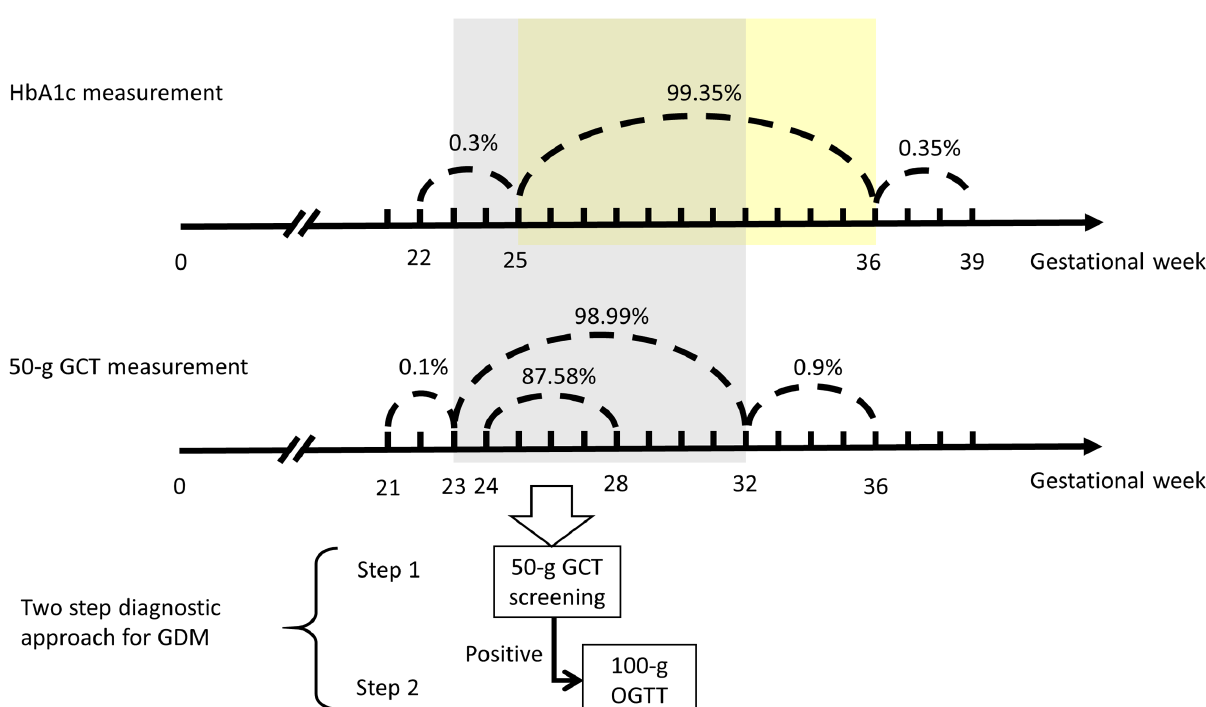
Fig 2. Gestational week of GDM screening using a two-step diagnostic approach and time frame for receiving the HbA1c test. GCT, glucosechallengetest; OGTT, oral glucosetolerancetest; GDM, gestational